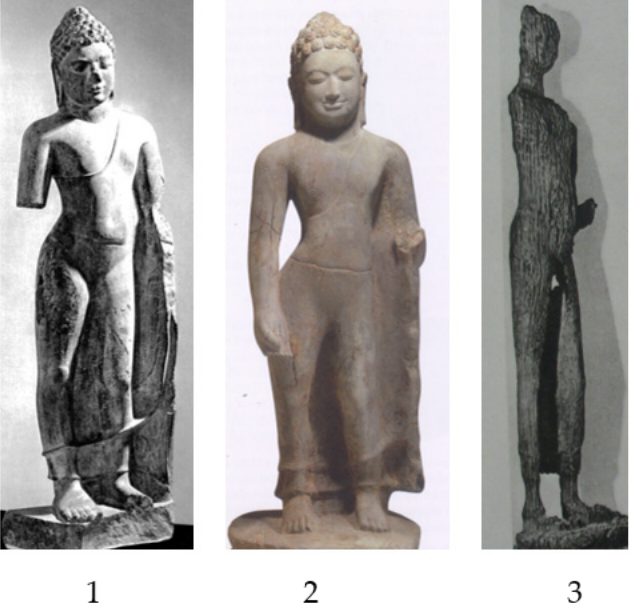
Figure 8. Standing Buddhas with diaphanous robe covering only the left shoulder (Type C) in the Mekong Delta. (1): Buddha, stone, excavated at the site of Vat Romlok, Angkor Borei,